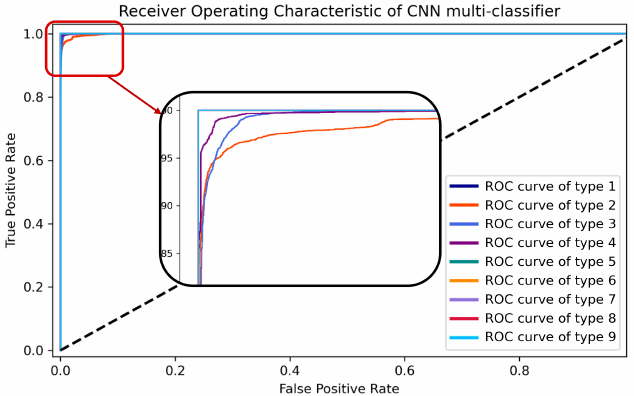
Figure 8. ROC curve of the CNN model